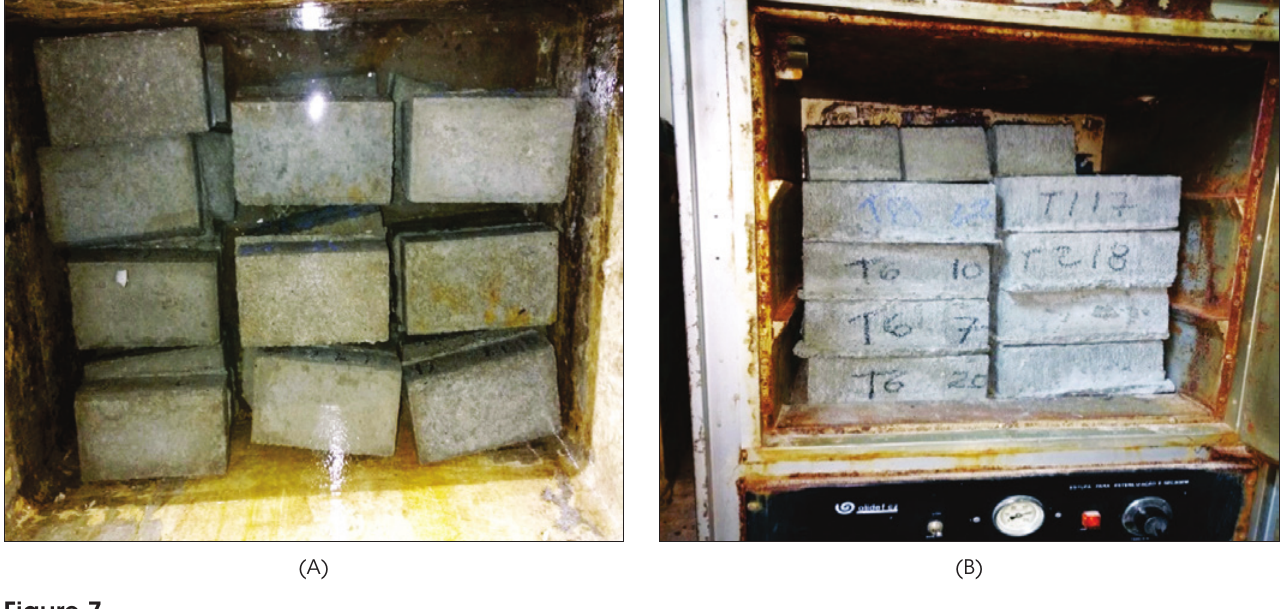
Absorption tests: (A) Immersed pavers; (B) Pavers in the